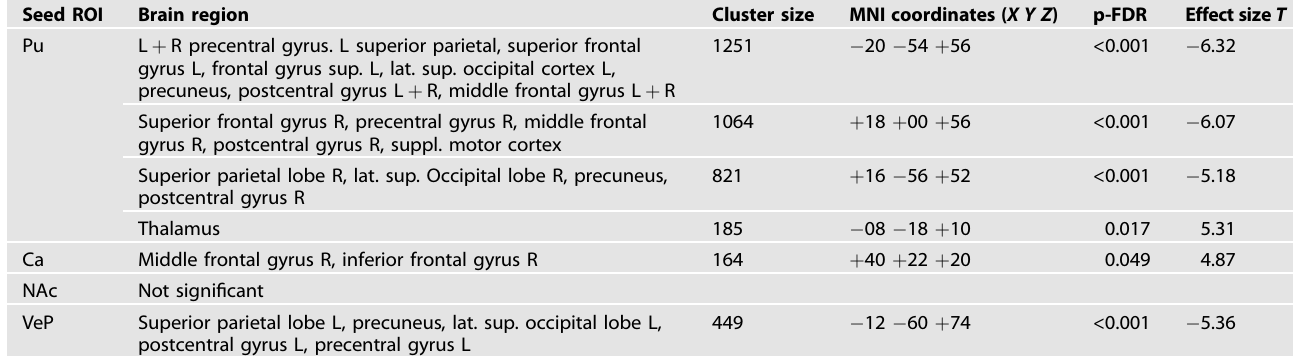
ROI region-of-interest, Pu putamen, Ca caudate, NAc nucleus accumbens, VeP ventral pallidum, L left, R right. The table gives results for the two-sided comparison ADHD>HC: ADHD>HC has positive effect sizes, HC> ADHD negative effect sizes. Representation of the signi fi cant clusters, their size in voxels, and their localization in MNI space as MNI coordinates in the order X Y Z , p-FDR, T , and beta-values. The brain region with the largest proportion of each cluster is listed. The threshold was set to 0.001 (uncorrected) at the voxel level and p-FDR = 0.05 at the cluster level.